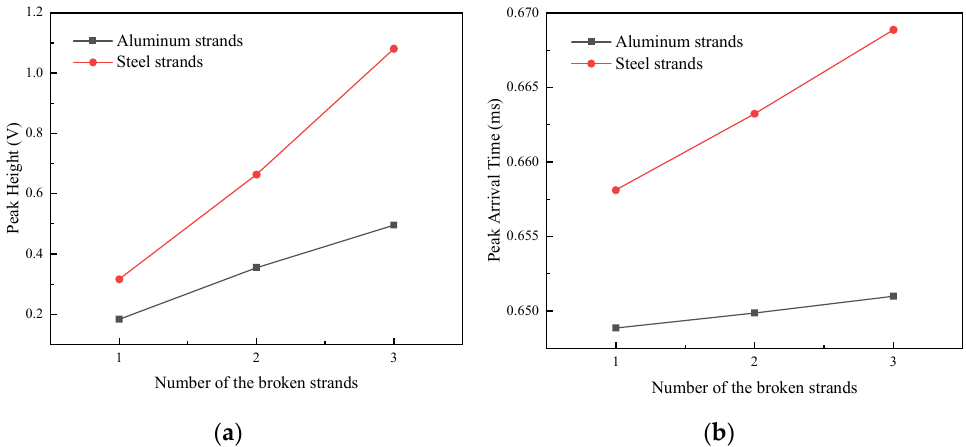
Figure 5. Feature peak height and peak arrival time of the different broken strands: ( a ) peak height; ( b ) peak arrival time.